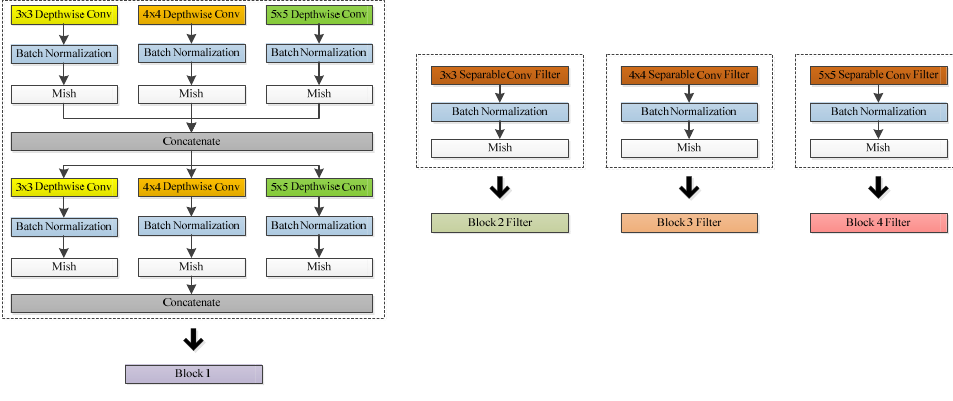
Figure 10. Four blocks of the model.